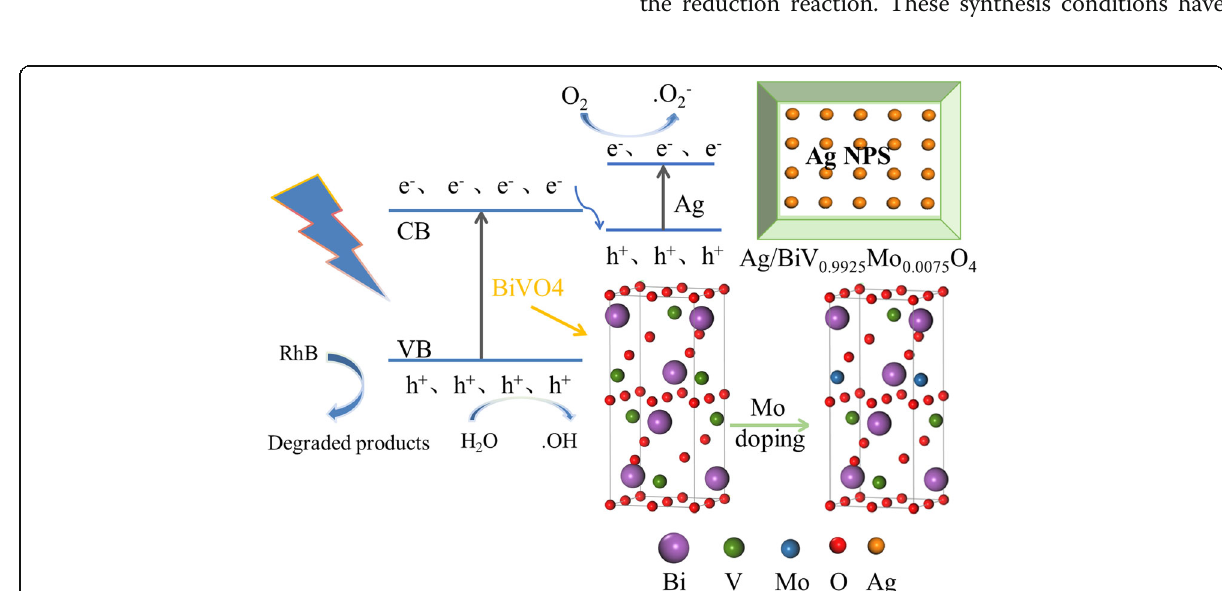
Fig. 13 Schematic mechanism of charge transfer in the Ag/BiV 0.9925 Mo 0.0075 O 4 composite systems under visible light